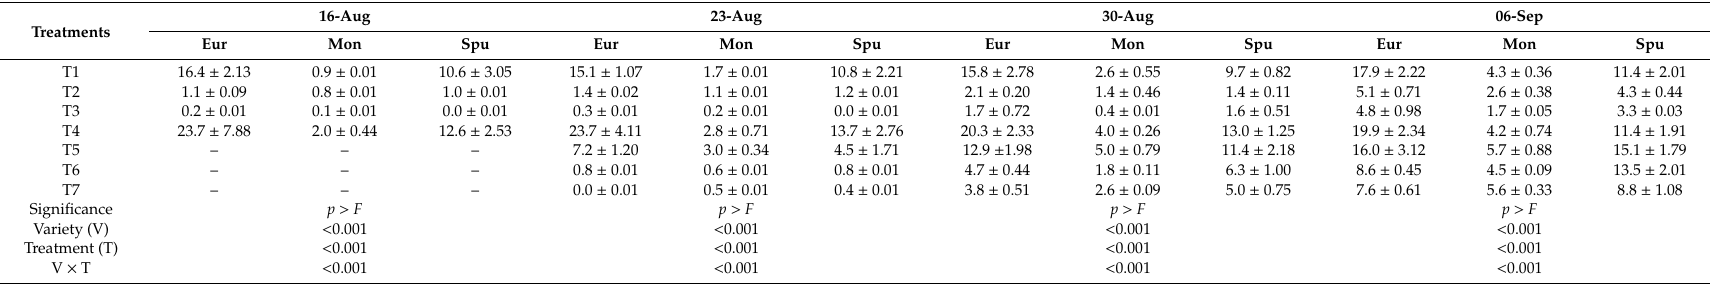
Table 5. Average ( ± standard error) length of the longest sprout (mm) of three varieties (Europa, Monalisa, Spunta) subjected to seven dormancy-breaking treatments applied during pre-planting storage condition (Experiment 1).